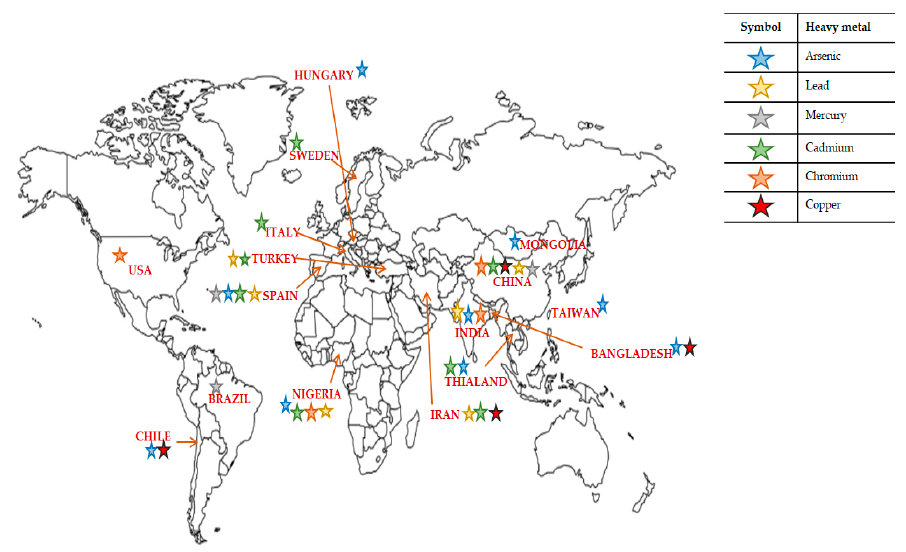
Figure 1. Global map of heavy metals showing countries where significant impact has been observed.